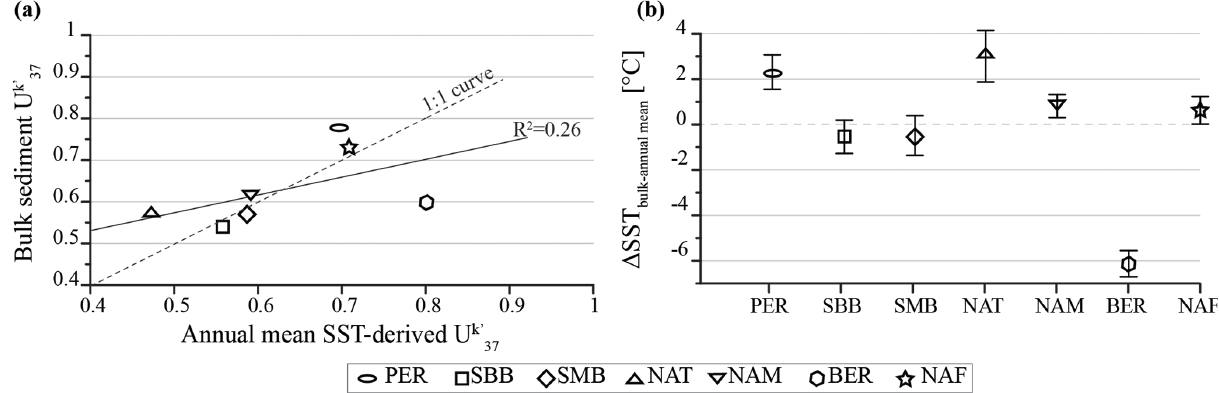
(cid:48) ratio from bulk core-top sediments 37